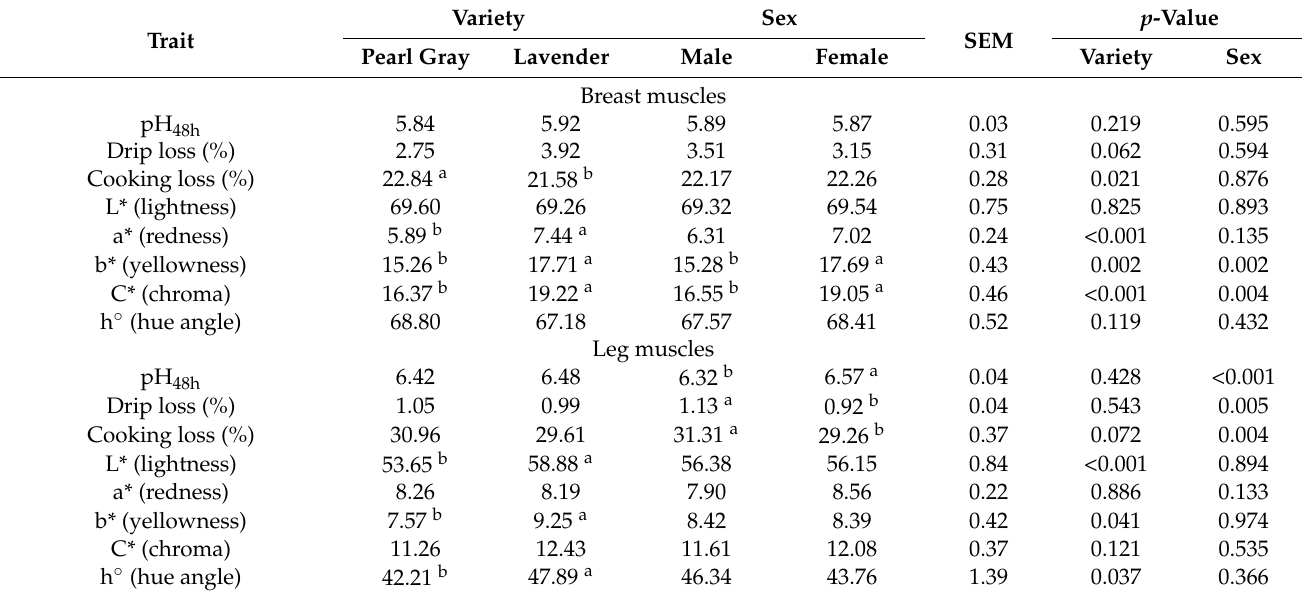
Table 4. Physicochemical properties of breast and leg muscles of male and female guinea fowl of pearl gray and lavender varieties (means ±